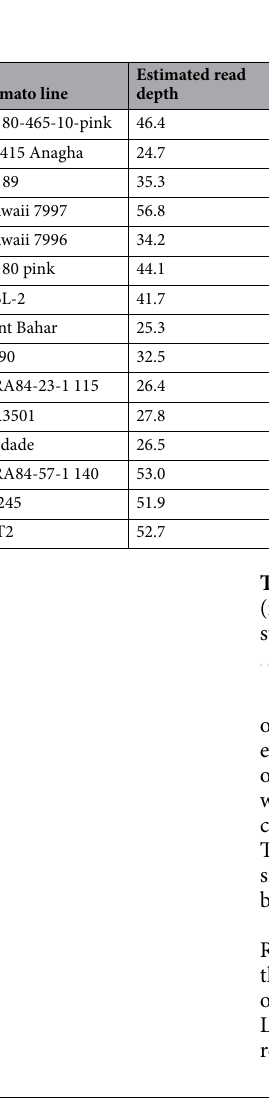
Table 1. Average resistance percentage of the highly resistant and highly susceptible tomato lines used for sequencing two weeks after inoculation with two different strains of Ralstonia sp, Pss4 (race 1, biovar 3, R . pseudosolanacearum ) and Pss1632 (race 3, biovar 2, R . solanacearum ), during the hot season (June–July) in 2018. Five individual plants with extremes in the phenotype (highly susceptible early in the evaluation, highly resistant late in the evaluation) were selected for sequencing.